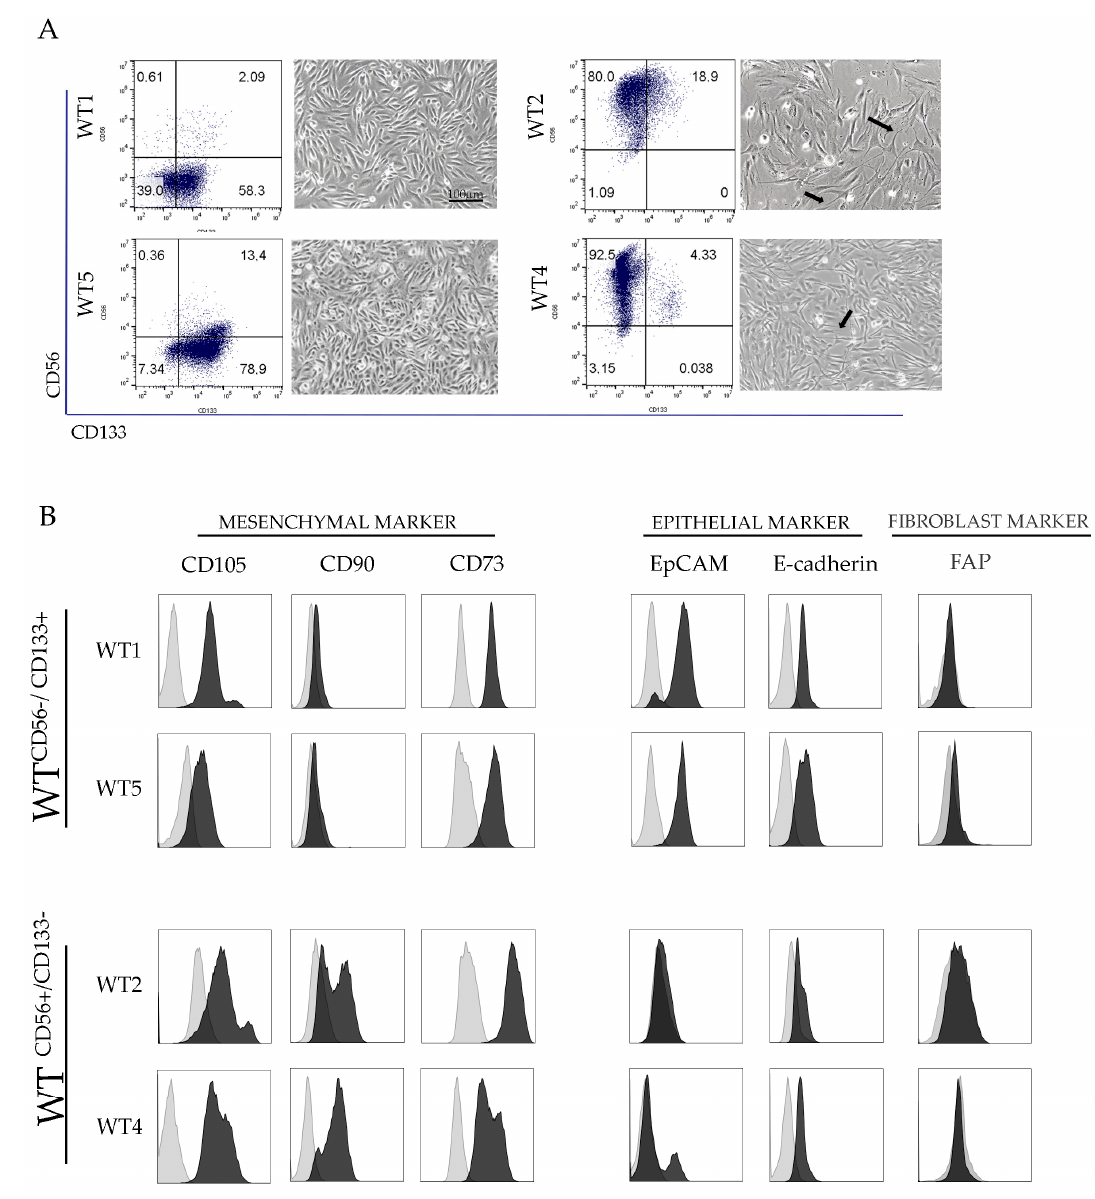
Figure 1. Phenotype characteristics of different Wilms’ tumor (WT) primary cultures. ( A ) Representative flow cytometry dot plot of CD56 and CD133 expression in WT primary cells and representative image of their morphology (arrows indicate cells displaying filamentous protrusions). ( B ) Surface expression of mesenchymal (CD105, CD73, CD90), epithelial markers (EpCAM and E-cadherin) or fibroblast marker (FAP) on different WT